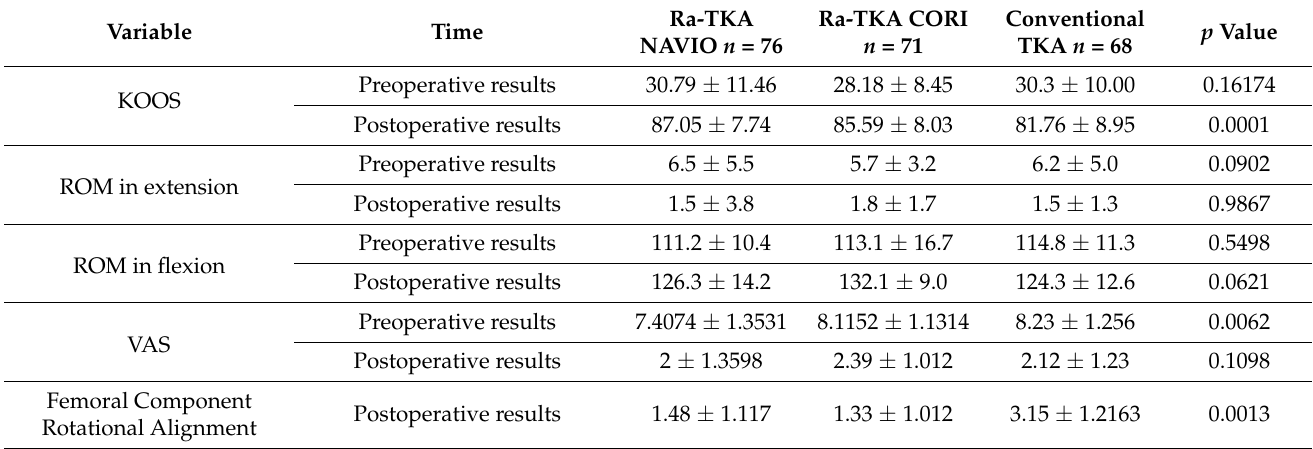
Table 3. Results of clinical and radiographic outcomes preoperatively and at 12 months follow up from the three